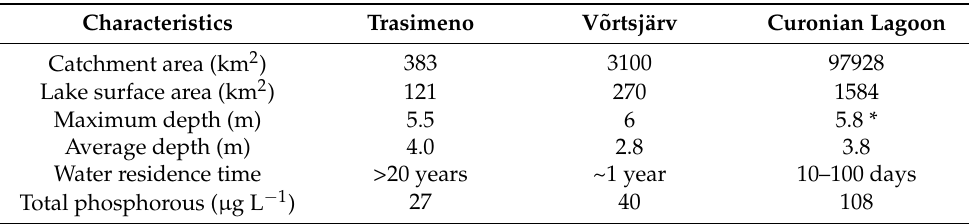
Table 1. Main features of Lake Trasimeno, Curonian Lagoon and Lake V õ